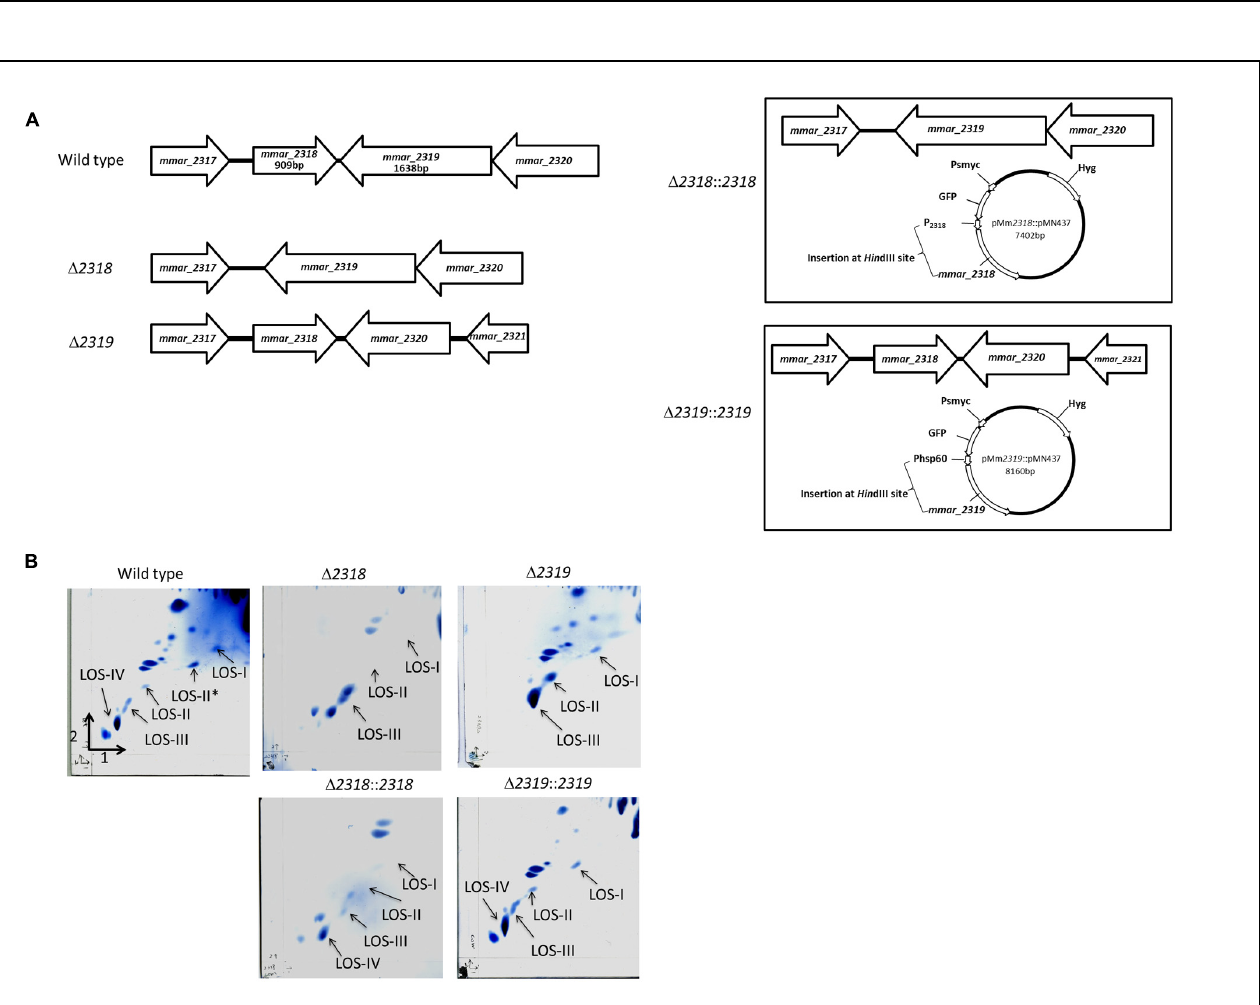
FIGURE 3 | The 2D-TLC profile of the polar lipid of M. marinum wild-type, deletion mutants and complementation strains. (A) The gene alignment of mmar_2318 and mmar_2319 deletion mutants and complementation strains. The (cid:2) 2318 and (cid:2) 2319 deletion mutants were created by unmarked deletion of mmar_2318 and mmar_2319 , respectively. pMm 2318 ::pMN437 and pMm 2319 ::pMN437 plasmids were used to create the epichromosomal complementation strains (cid:2) 2318 :: 2318 and (cid:2) 2319 :: 2319 , respectively. (B) The 2D-TLC profile of the polar lipid of M. marinum . Using 2D-TLC, extracted M. marinum polar lipids were separated by chloroform/methanol/water (60:30:6, v/v/v) in the first direction and by chloroform/acetic acid/methanol/water (40:25:3:6, v/v/v/v) in the second direction. The plates were charred with ceric ammonium molybdate. Accumulation of LOS-III and deficiency of LOS-IV were observed in the (cid:2) 2318 and (cid:2) 2319 mutants. The 2D-TLC lipid composition profiles of the (cid:2) 2318 :: 2318 and (cid:2) 2319 :: 2319 complementation strains were restored to that of the wild-type strain.